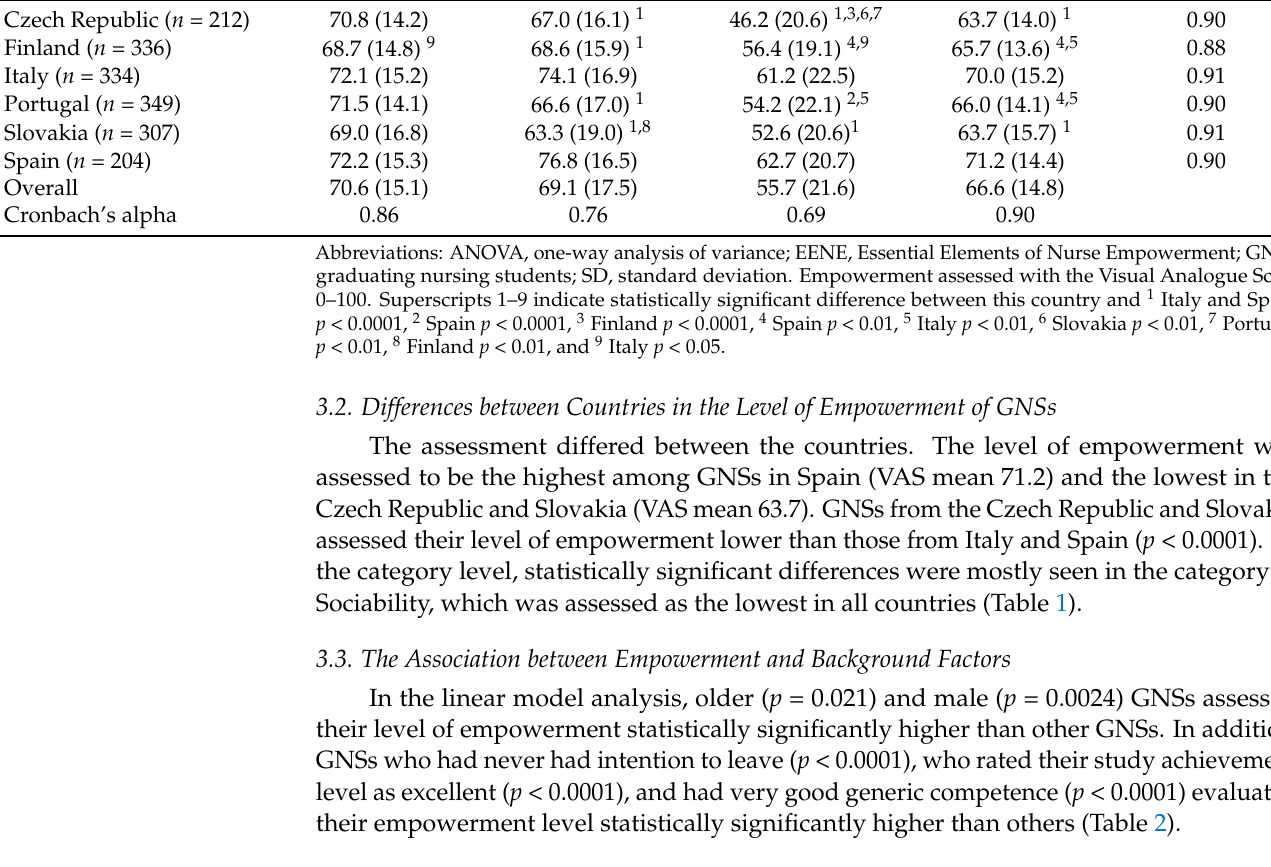
Table 2. The association between GNSs’ background factors and their level of empowerment, analyzed with a linear